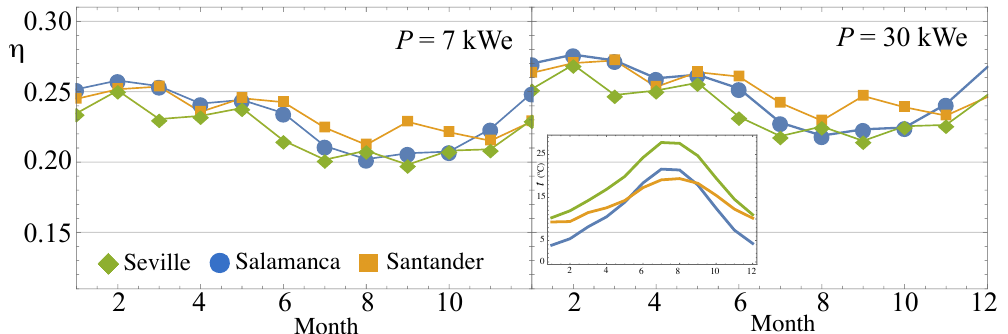
Figure 9. Monthly evolution of the overall efficiency for the three locations considered and two power levels (recuperated layout). The inset displays the monthly average temperature profile in each location.